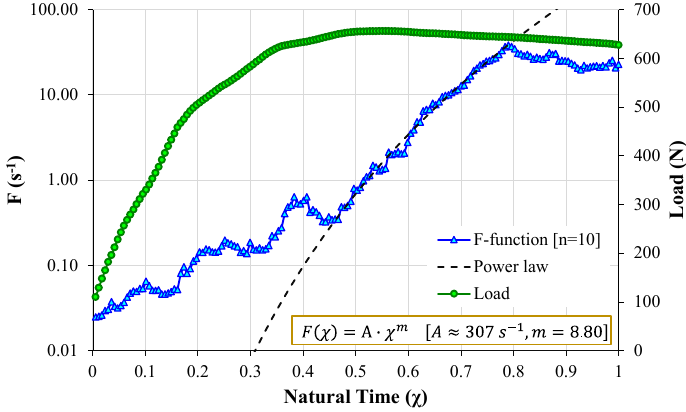
Figure 5. The evolution in the Natural Time domain of the F -function and the load imposed for the notched specimens under three-point bending.